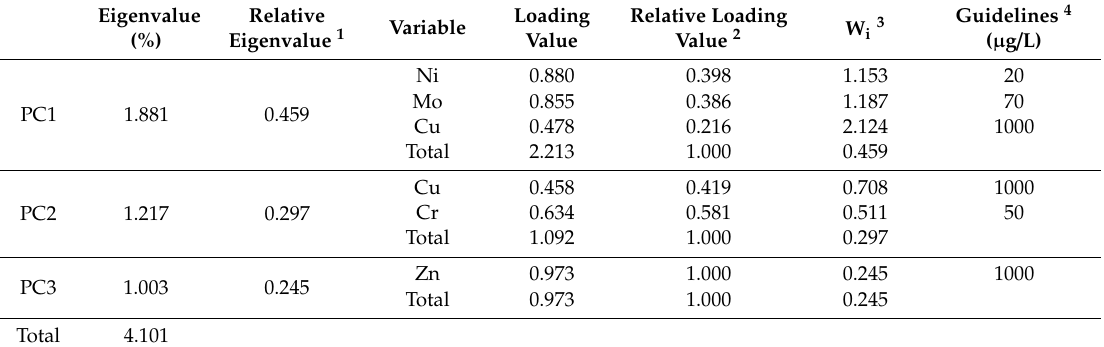
Table 5. Weights for the dissolved heavy metals in the Lancangjiang River.